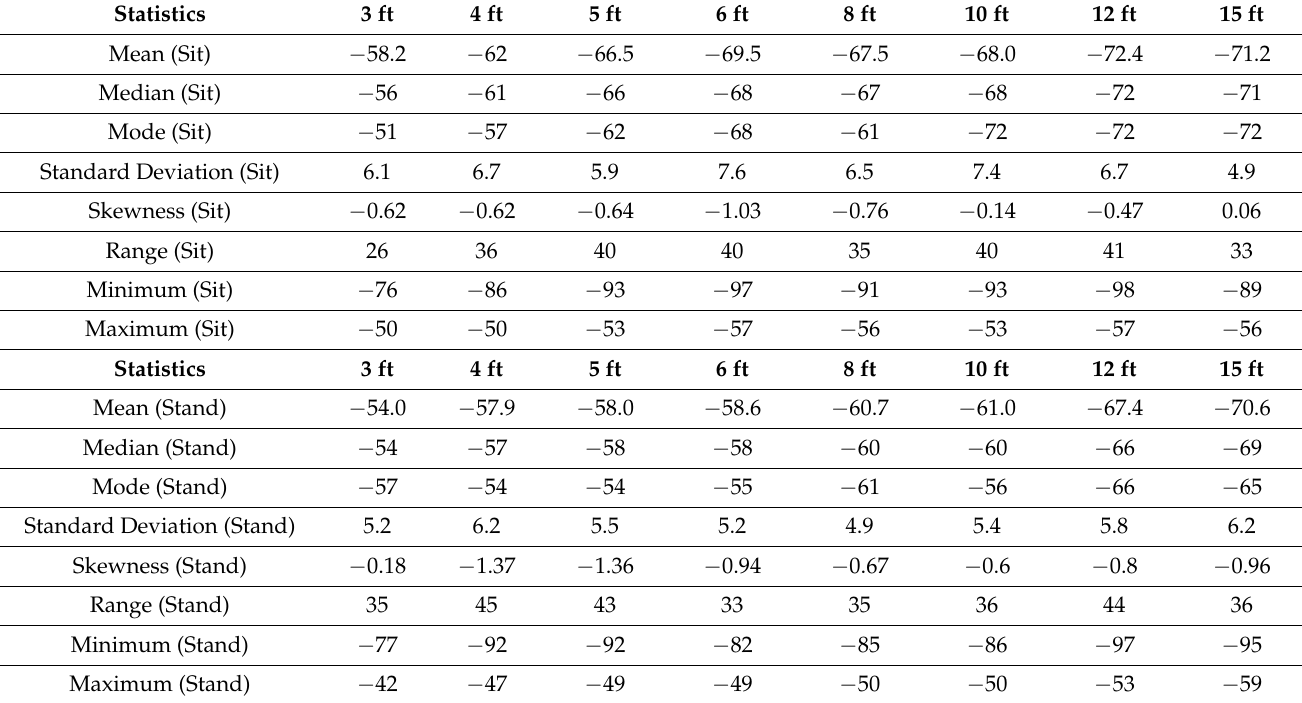
Table 1. Statistics of RSSI measured from different distances (Sit and Stand cases) (source: PACT